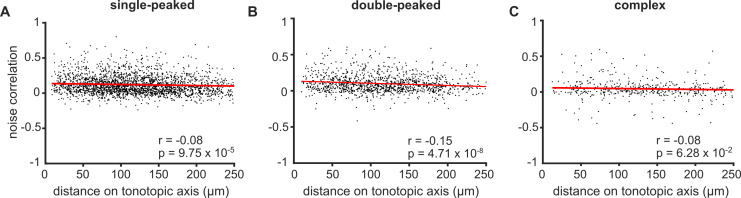
Noise correlations in neurons with single-peaked, double-peaked and complex FRAs.(A) Noise correlations for pairs of single-peaked neurons imaged simultaneously, as a function of the distance between the two neurons along the tonotopic axis. (B) Same as (A) for double-peaked neurons. (C) Same as (A) for complex neurons. Red lines indicate the best linear fit to the data. Pearson’s correlation coefficient (r) and p-value (p) are shown.